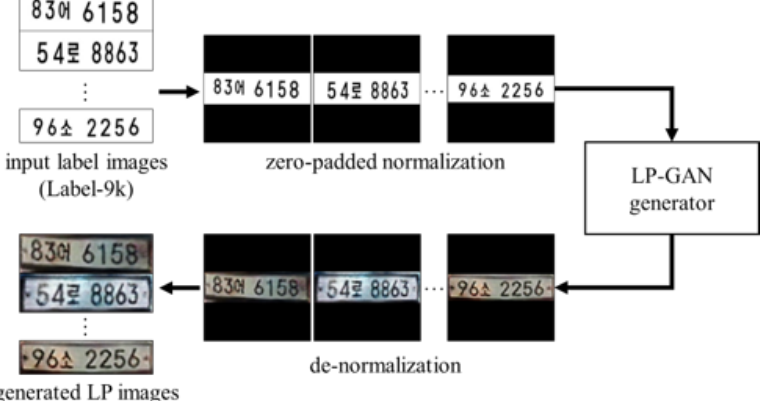
Figure 5. Generation of LP images using